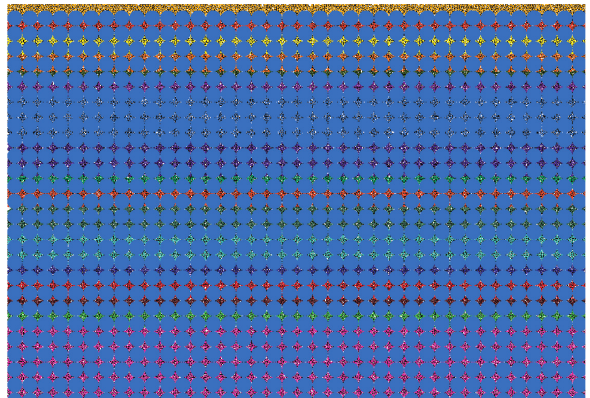
Figure 7: Measurement of circular